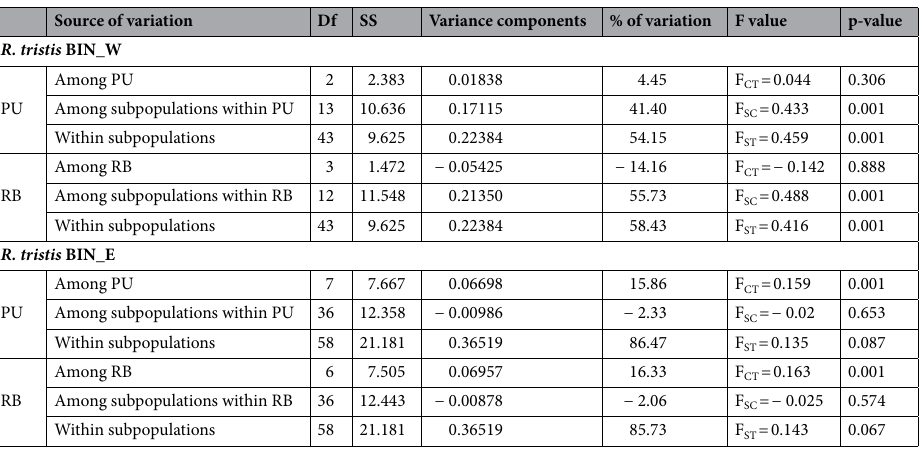
Table 2. Analysis of molecular variance (AMOVA) calculated from 161 5 ′ COI mtDNA sequences of R. tristis (BIN_W, BIN_E) from springs and streams in the W Carpathians. The subpopulations are defined as individuals of one sampling site (see Table S3). Df degree of freedom, SS sum of squares, PU physiographic units, RB river